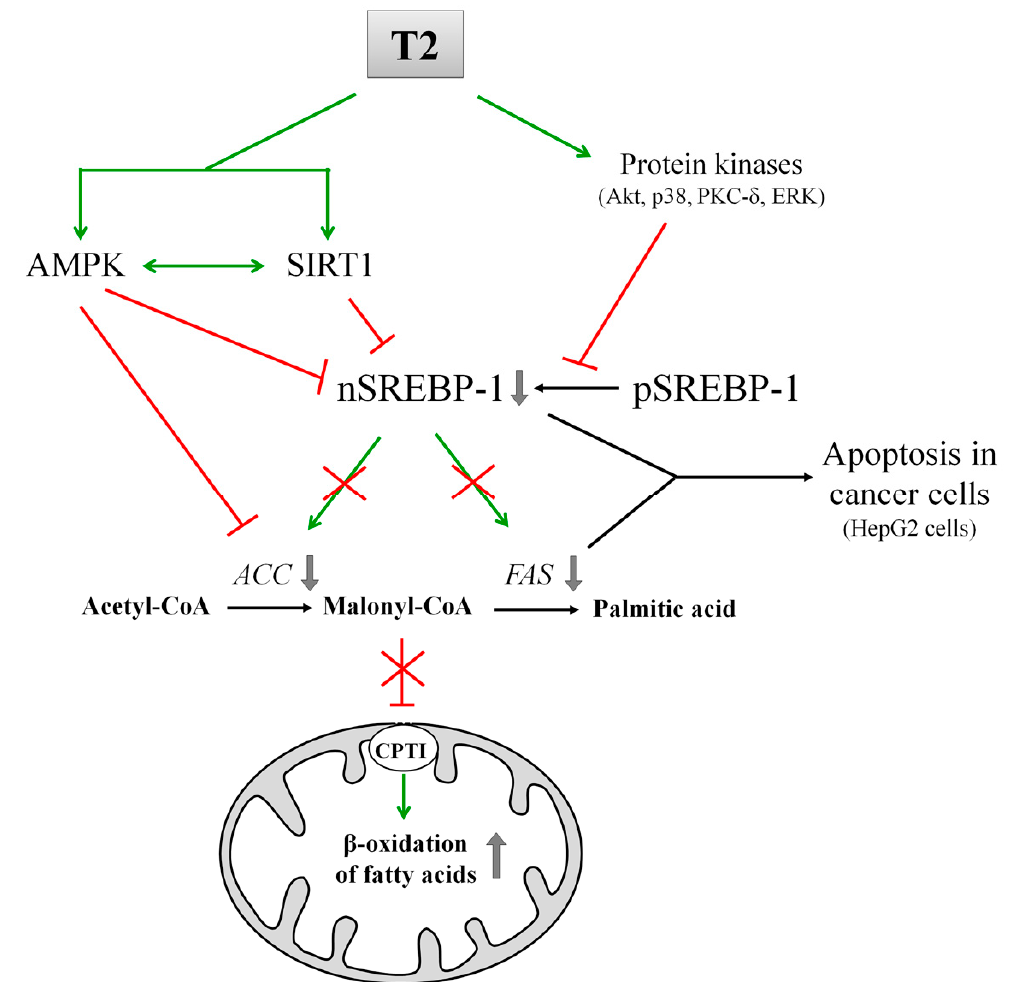
Figure 2. Scheme of the inhibition of fatty acid synthesis mediated by T2. Green line-arrow, Stimulation; Red T-bar, Inhibition; Red cross, Loss of stimulation/inhibition consequent to T2 action. Abbreviations: ACC, Acetyl-CoA carboxylase; AMPK, AMP-activated protein kinase; CPTI, Carnitine palmitoyltransferase I; FAS, Fatty acid synthase; nSREBP-1, nuclear sterol regulatory element-binding protein 1; pSREBP-1, precursor sterol regulatory element-binding protein 1; SIRT1, Sirtuin 1.